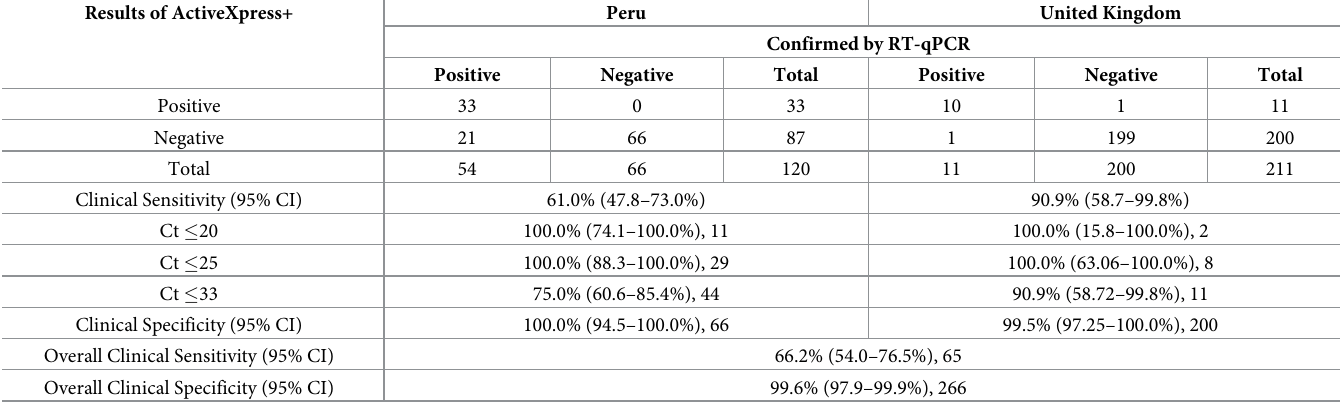
Table 3. Results and clinical sensitivity and specificity of the ActiveXpress+ COVID-19 Complete Testing Kit based on COVID-19 RT-qPCR result in the UK and Peru. Results of